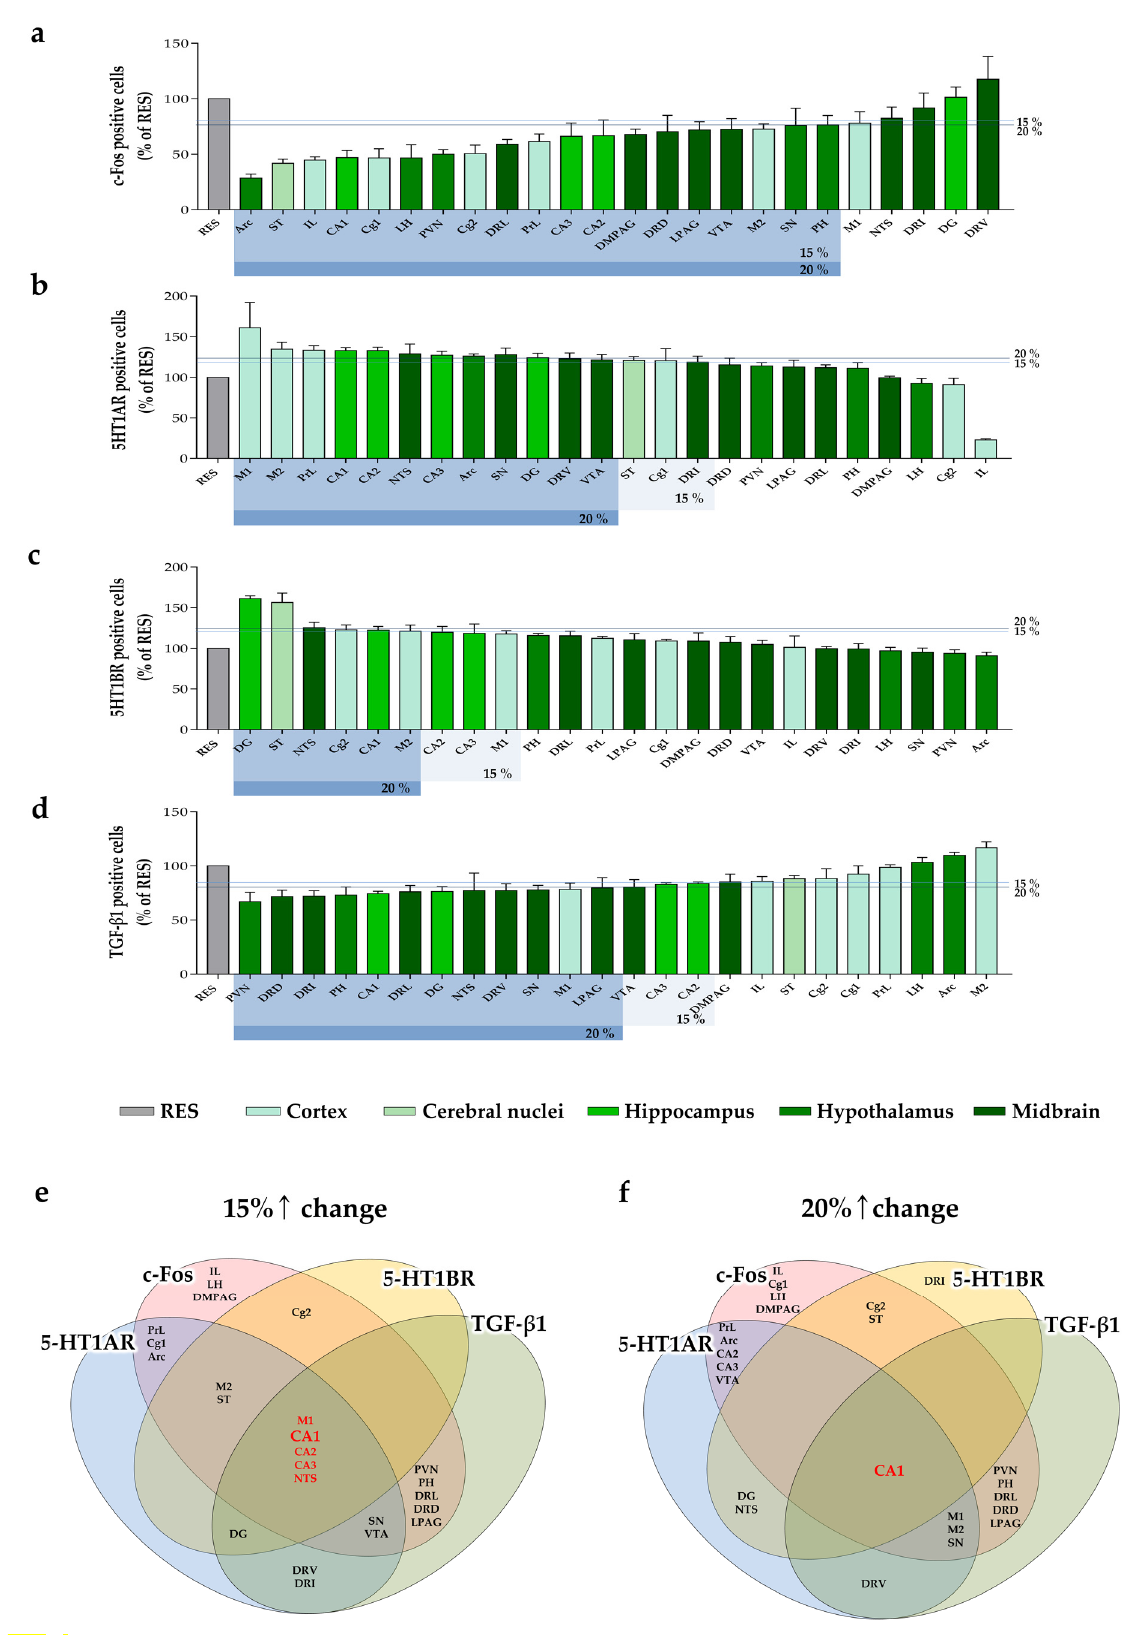
Figure 9. Identification of the major brain regions based on the changes in the expression of c-Fos and 5-HT1A/B receptors and TGF- β 1 following myelophil (MYP) treatment. Percentage of cells positive for c-Fos ( a ), 5-HT1A receptor (5-HT1AR)